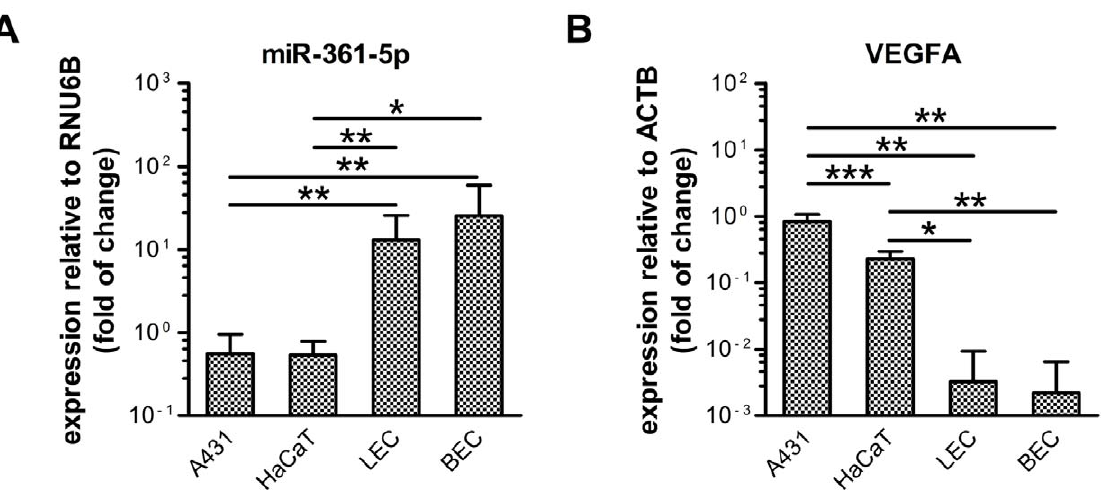
Figure 3. VEGFA and miR-361-5p expression levels are inversely correlated in human skin-derived cell lines. qRT-PCR analysis of miR- 361-5p (A) and VEGFA (B) expression in A431, HaCaT, primary human dermal lymphatic (LEC) and blood endothelial cells (BEC). Fold differences 6 S.D. in expression levels with regards to the references (RNU6B and ACTB, for miRNA-361-5p and miRNA-361-5p, respectively) are plotted. Data represent at least three independent experiments performed in duplicate. Two-tailed, unpaired t -tests were used to calculate P values (one, two and three asterisks denote P values , 0.05, , 0.01, and , 0.001, respectively).